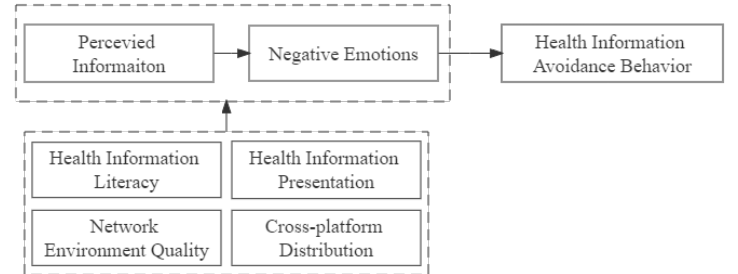
Figure 1. Research